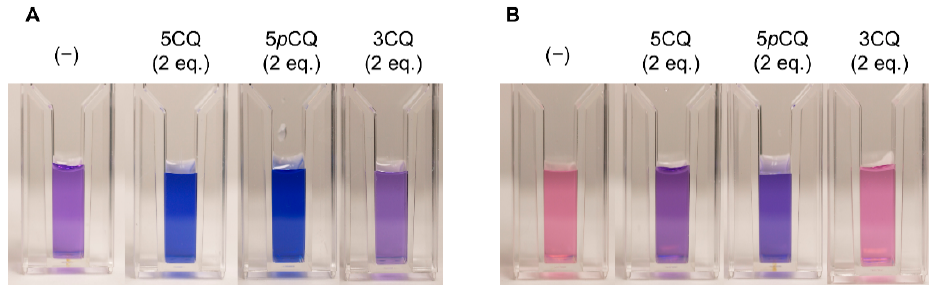
Figure 1. Color of reproduced solutions via mixing of Dp3G ( 1 , 0.1 mM) and Al 3+ (0.1 mM, 1 eq. to 1 ) with 0.2 mM (2 eq. to 1 ) of co-pigment, 5CQ ( 2 ), 5 p CQ ( 3 ), or 3CQ ( 4 ) in buffered solutions of 2 mM. ( A ) Solutions mixed at pH 4.0. ( B ) Solutions mixed at pH 3.2.